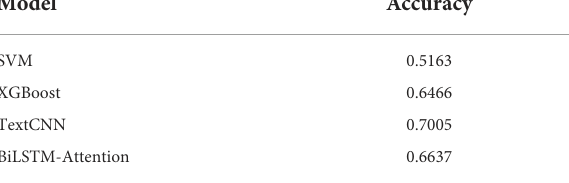
TABLE 1 Results of sentence classification.